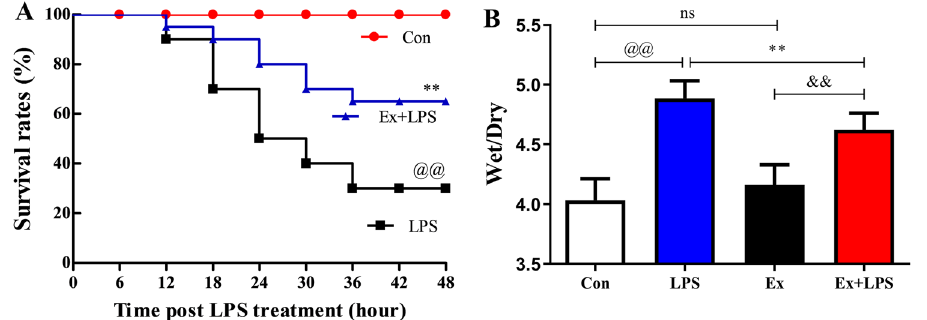
Figure 10. 4 weeks of exercise pretreatment improved mortality and W/D. ( A ) Survival rate analysis, ( B ) Detection of W/D in lung tissue. @ P < 0.05, Con versus LPS groups; * P < 0.05, LPS versus Ex + LPS groups; & P < 0.05, Ex versus Ex + LPS groups. W/D wet weight/dry weight